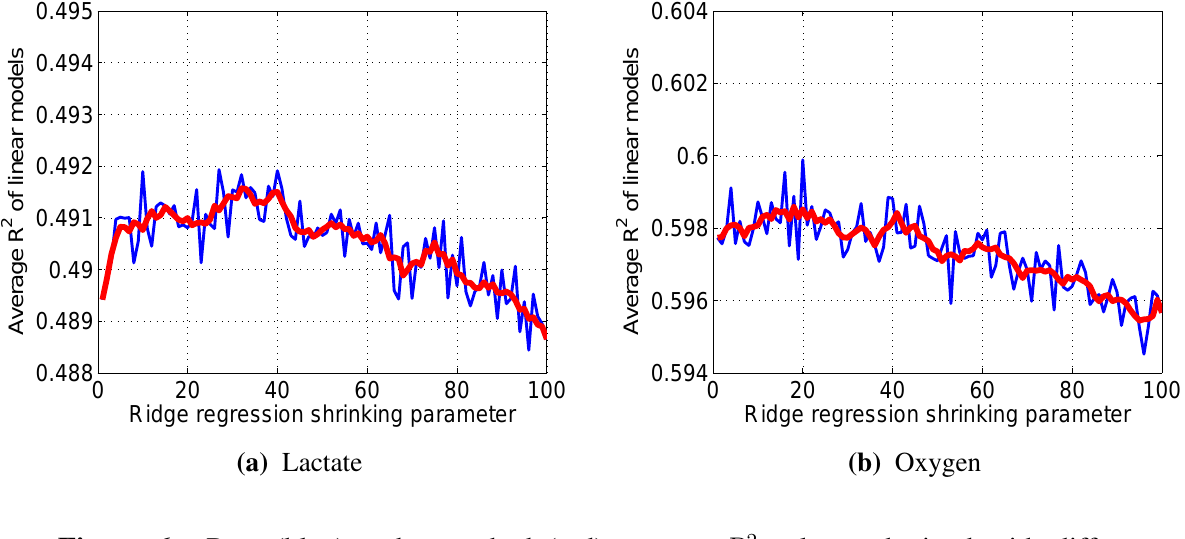
Figure 6. Raw (blue) and smoothed (red) average R 2 values, obtained with different shrinkage parameter λ .